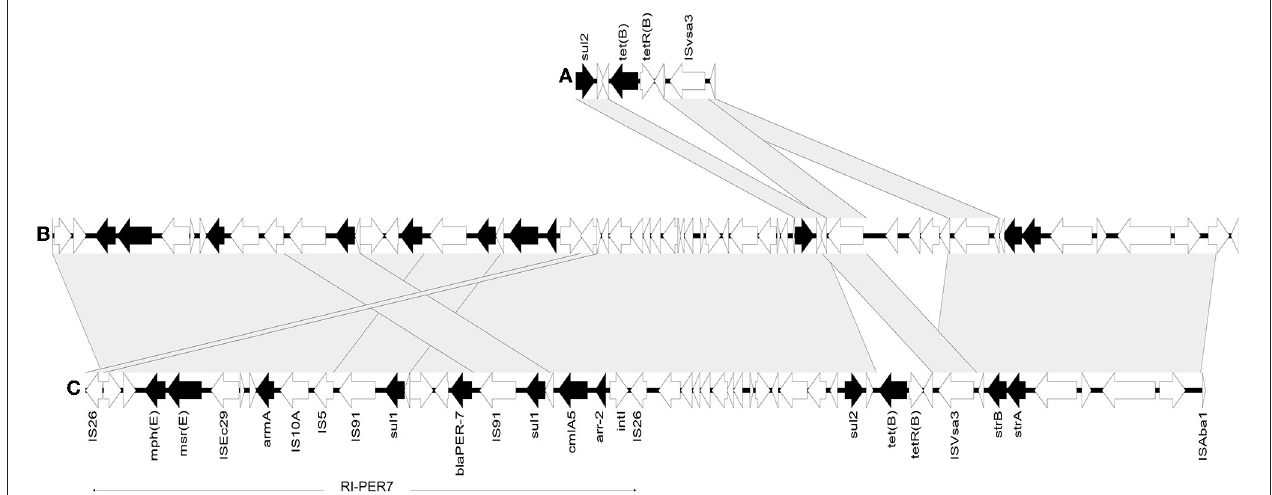
FIGURE 3 | Comparative genomic analysis of the partial sequence of M03 plasmid and the closely similar plasmid pPM194229_1(CP050433.1). (A) pPM194229_1 plasmid sequence region [218446-224334 bp]. (B) pPM194229_1 plasmid sequence region [1-50187 bp]. (C) M03 plasmid partial sequence. Arrows correspond to open reading frames, and black ones denote resistance genes. Gray shadings highlight regions of 99% or more nucleotide